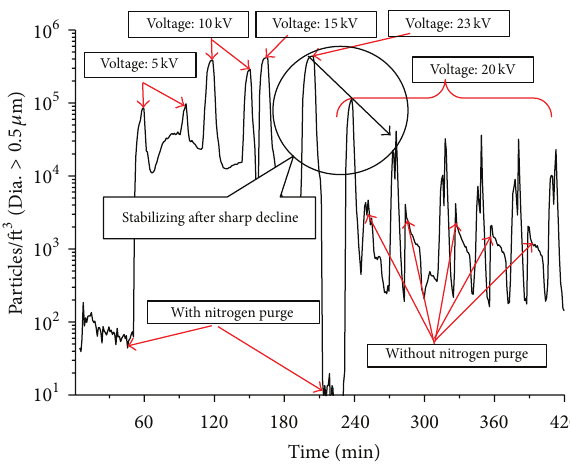
Figure 6: Plot of the SG-III slab amplifier aerosol concentrations during the first flashlamp